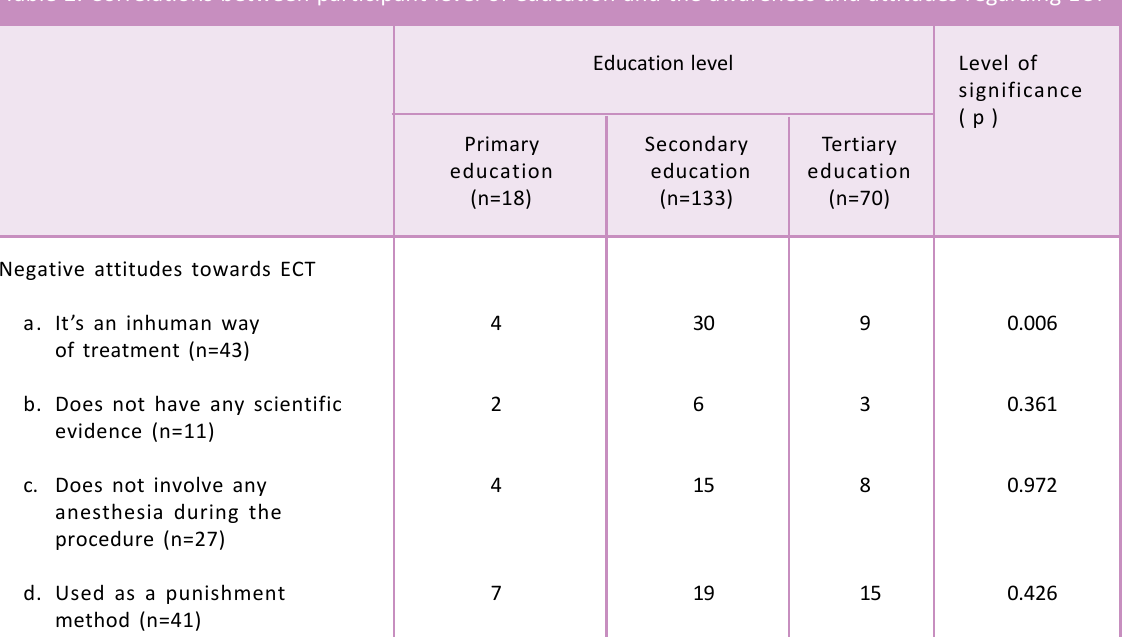
Table 2. Correlations between participant level of education and the awareness and attitudes regarding ECT